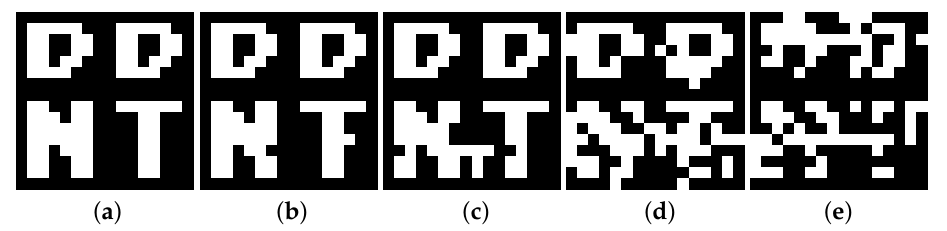
Figure 5. Examples of the extracted watermarks (WMs) according to BER: ( a ) 0, ( b ) 0.78, ( c ) 3.51, ( d ) 10.93, ( e ) 21.09.